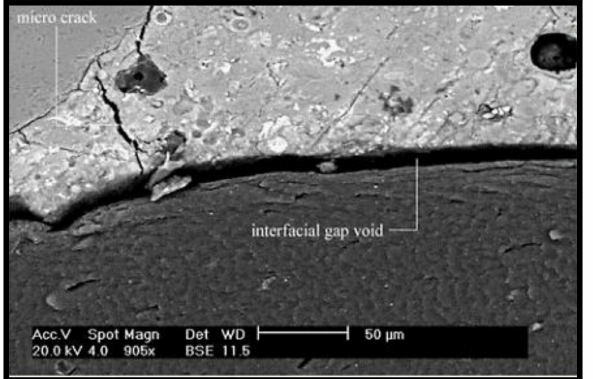
Figure 7. SEM image showing the lack of proper bonding between the CR and hardened cement matrix at the interface